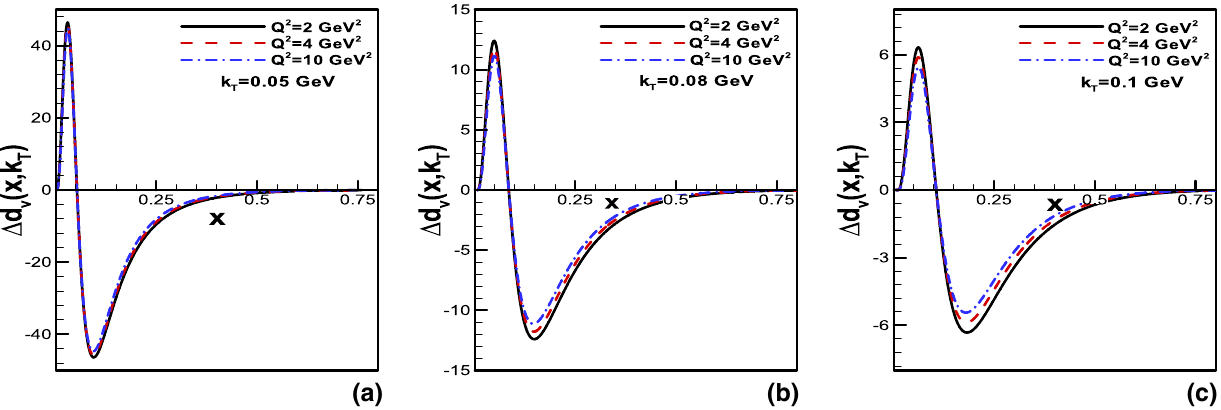
Fig. 12 The x -distribution of polarized down valence quark at a k T = 0 . 05 GeV, b k T = 0 . 08 GeV and c k T = 0 . 1 GeV. The TMD polarized valence distributions are plotted at three values of Q 2